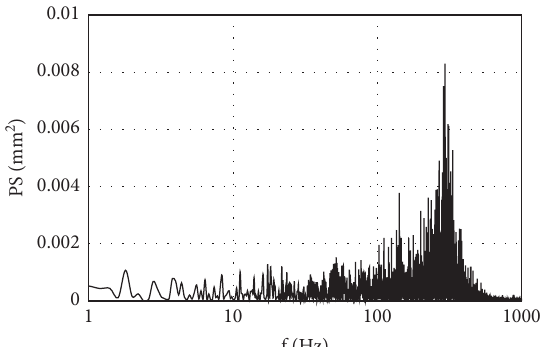
Figure 12: Power spectrum of shock oscillations for roughness at X / C � 0.16 and Ra � 20 μ